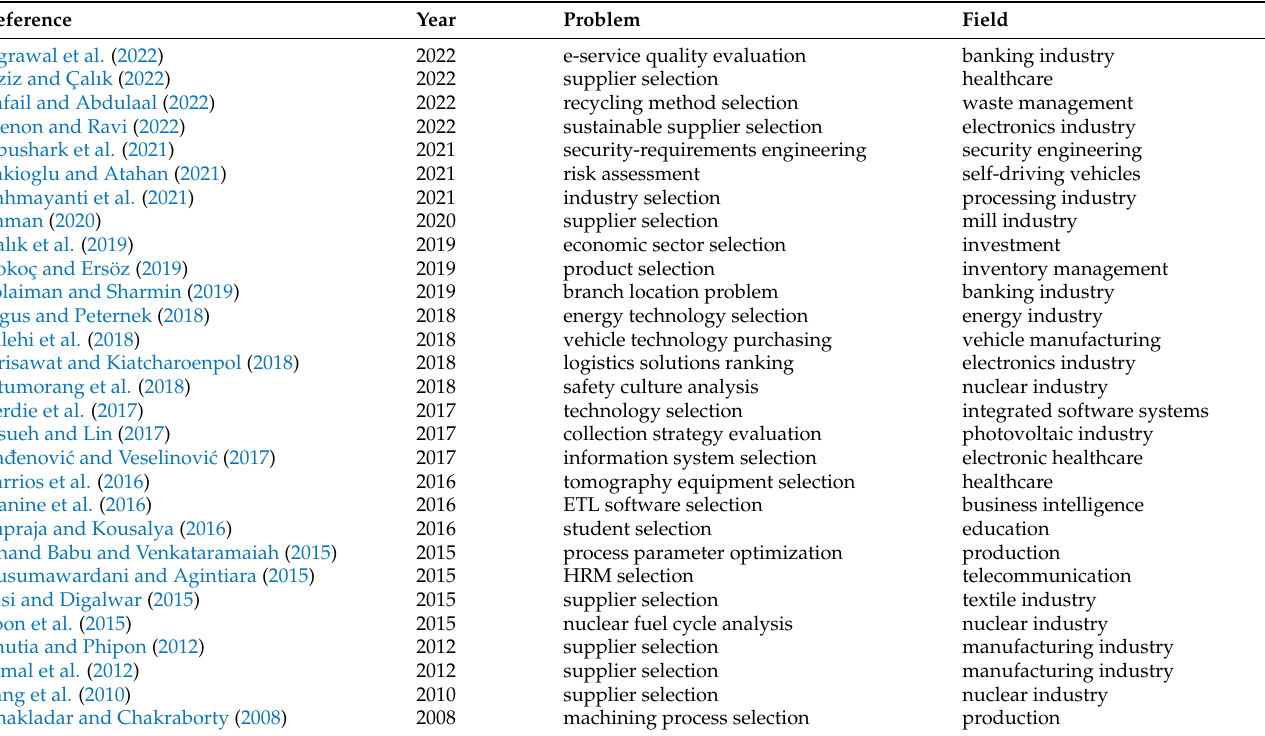
Table 1. References of AHP-TOPSIS approach applications.